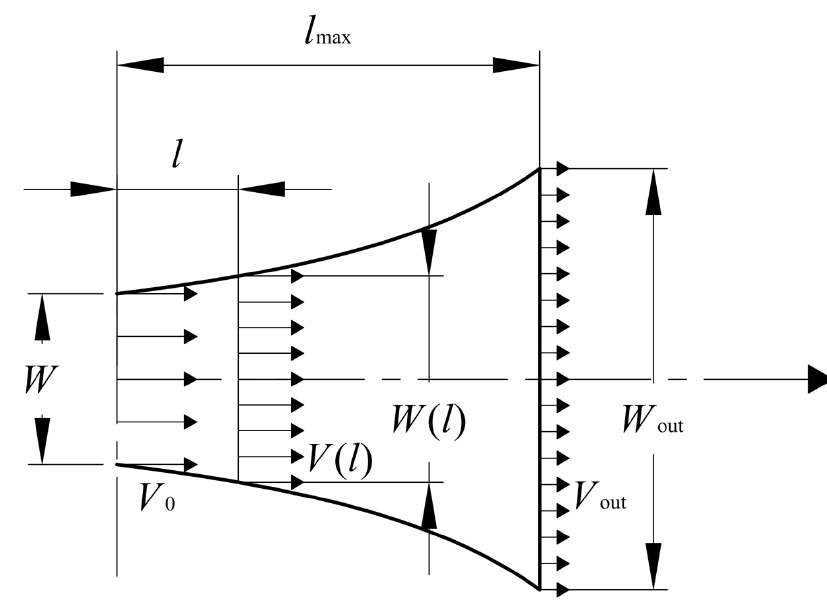
Figure 8. Top view of the last section of the diffuser.